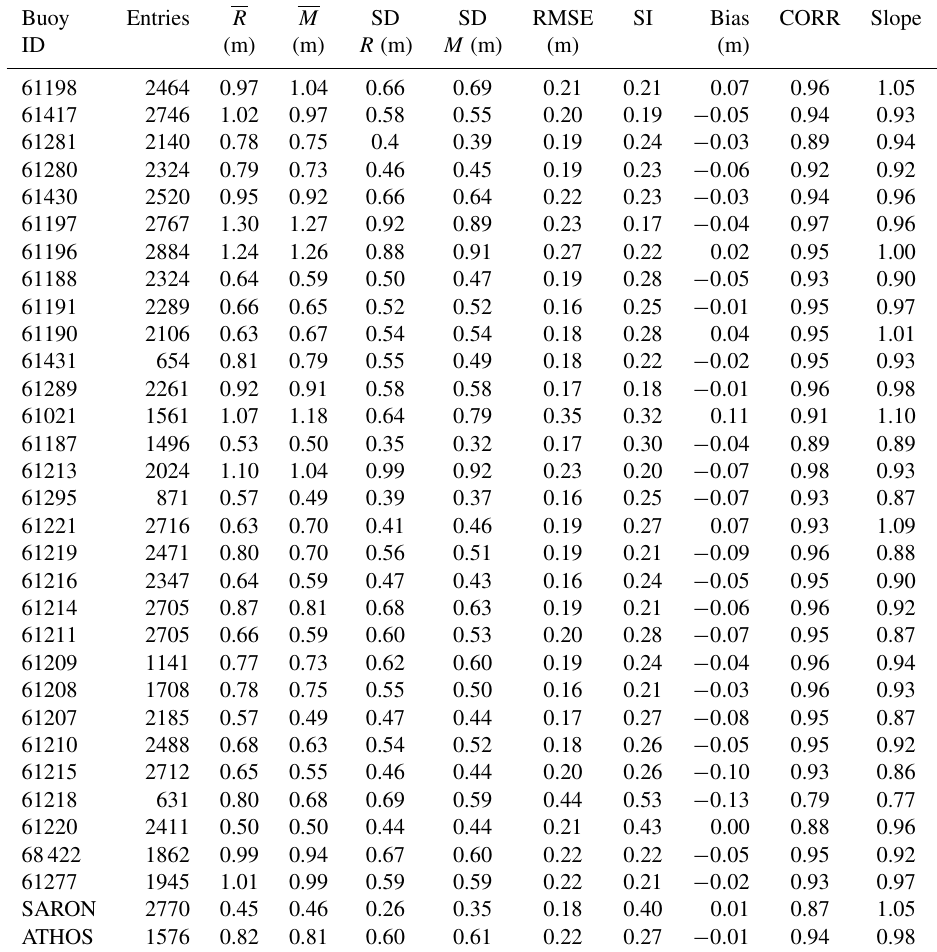
Table 2. Med-waves H s evaluation against wave buoy H s , for each individual buoy location, for a 1-year period